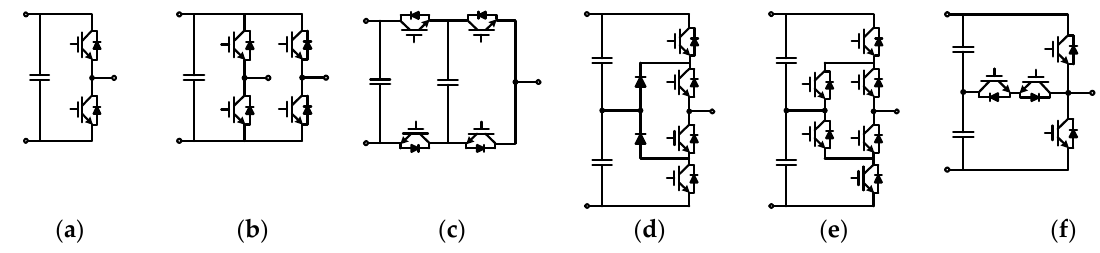
Figure 2. Basic switching cells. ( a ) 2L cell, ( b ) 3L HB cell, ( c ) 3L FC cell, ( d ) 3L NPC cell, ( e ) 3L ANPC cell, ( f ) 3L T ‐ type cell.